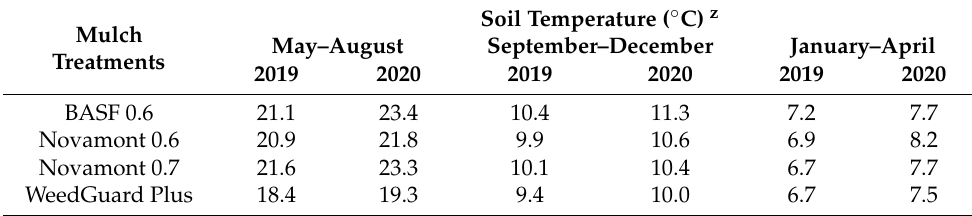
Table 4. Average soil temperature from May to August 2019/2020 and 2020/2021 at the experimental site in northwestern Washington,